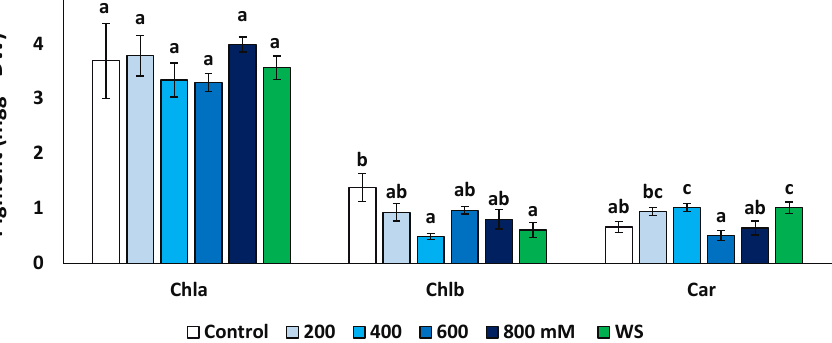
Figure 5. Variation of photosynthetic pigments contents in Limonium angustebracteatum leaves after one month of treatment with the indicated NaCl concentrations or one month of water stress (WS). Means ± SE, n = 6. For each pigment, different lowercase letters above the bars indicate significant differences between treatments, according to Tukey’s test ( α = 0.05). Abbreviations: Chla, chlorophyll a; Chlb, chlorophyll b; Car, carotenoids.